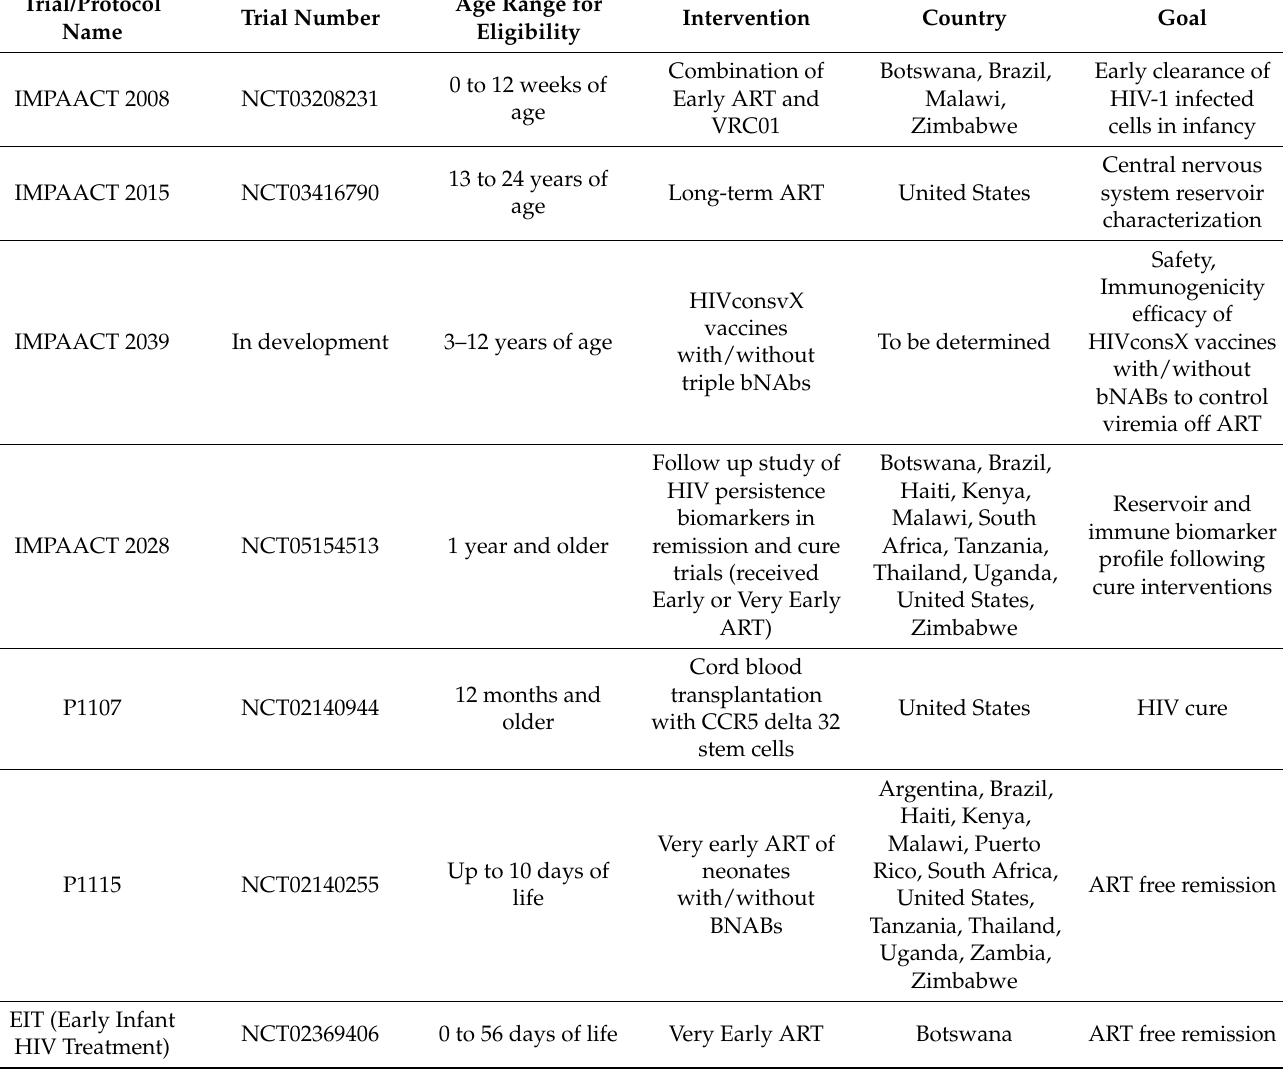
Table 1. Clinical trials towards HIV-1 remission in children. (adapted from the Treatment Action Group (TAG HIV Science) website)